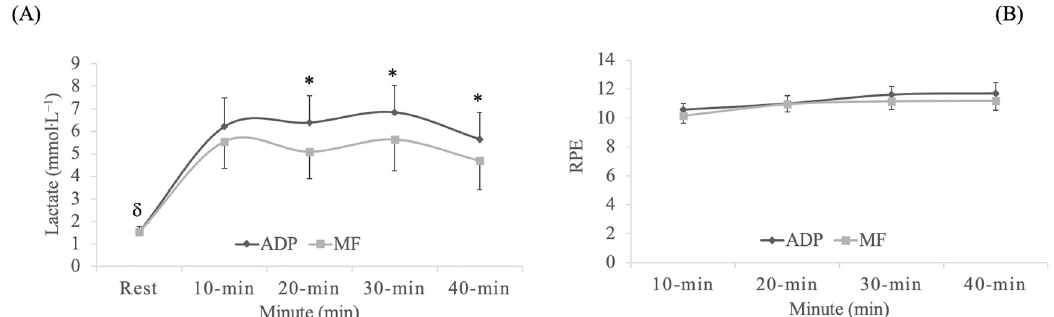
Figure 2. Blood lactate levels ( A ) and rating of perceived exertion (RPE) ( B ) during aerobic dance sessions. ∗ Significantly different from marble floor at times 20-min, 30-min and 40-min, p ≤ 0.01. Data are provided as mean and 95% confidence intervals (95% CI). δ Significantly different from checkpoint at times10-min, 20-min, 30-min and 40-min in both experimental conditions, p < 0.001. Abbreviations used: ADP = air dissipation platform; MF = marble floor (hard surface).